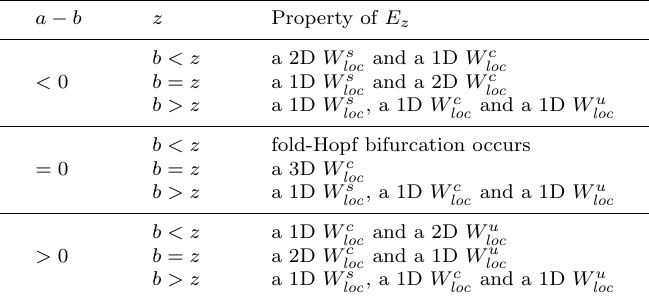
Table 3. The property of equilibrium E z of system